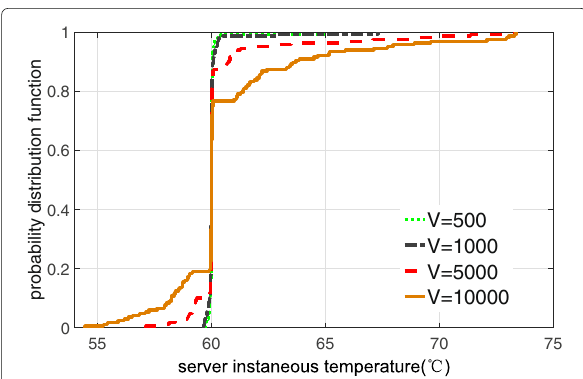
Fig. 16 The probability distribution function of server instantaneous temperature under quadratic policy vs. V